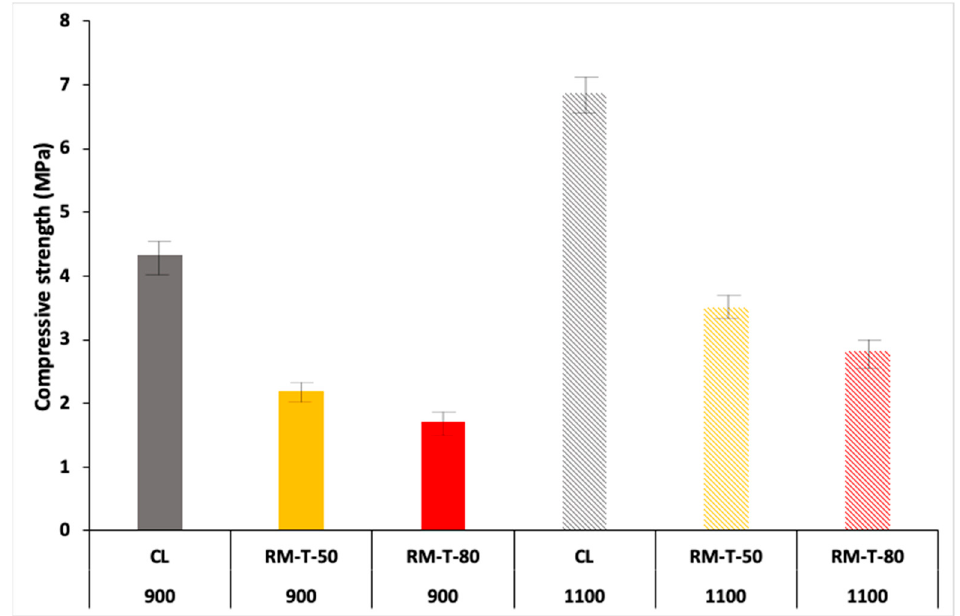
Figure 7. Compressive strength of the samples after